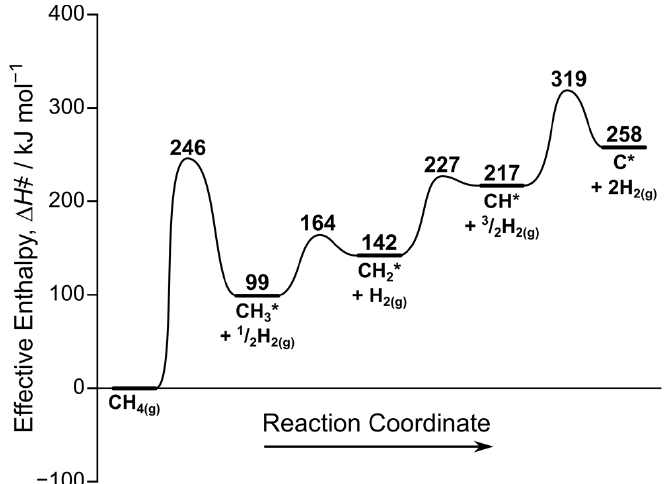
Figure 3. DFT-predicted reaction coordinate diagram for methane dehydrogenation on Ni 2 P(001) surface constructed using Equation (5) at 1123 K. Each CH x species is adsorbed in its preferred adsorption site as discussed in Section